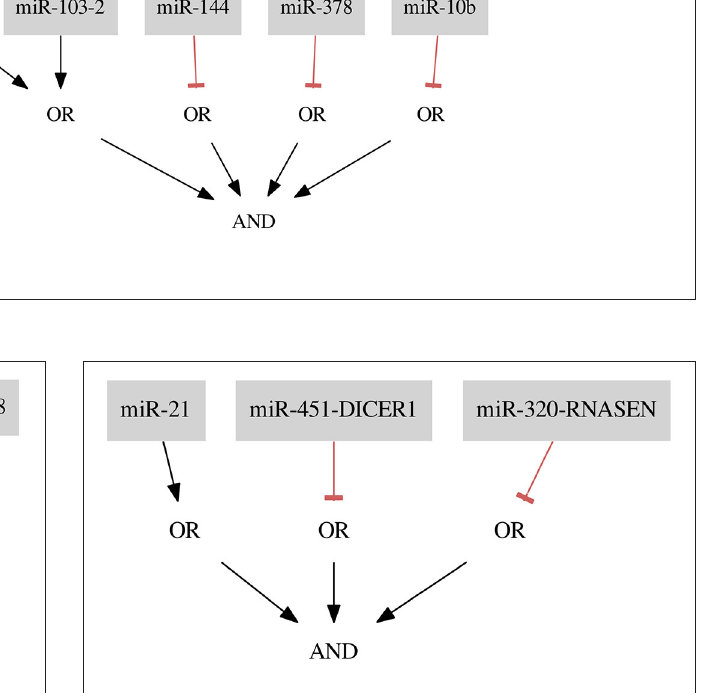
FIGURE 7 | Classifier for the breast cancer Her2 + data separating samples with one false positive